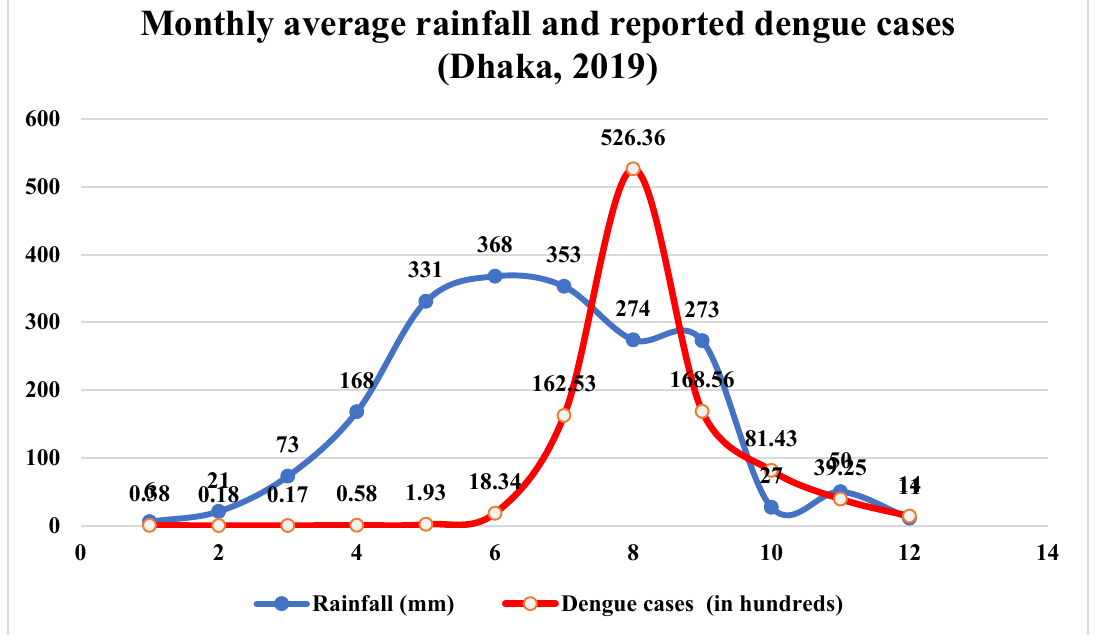
Figure 7. Monthly average rainfall and dengue cases (100×) in Dhaka City (January to December), 2019.